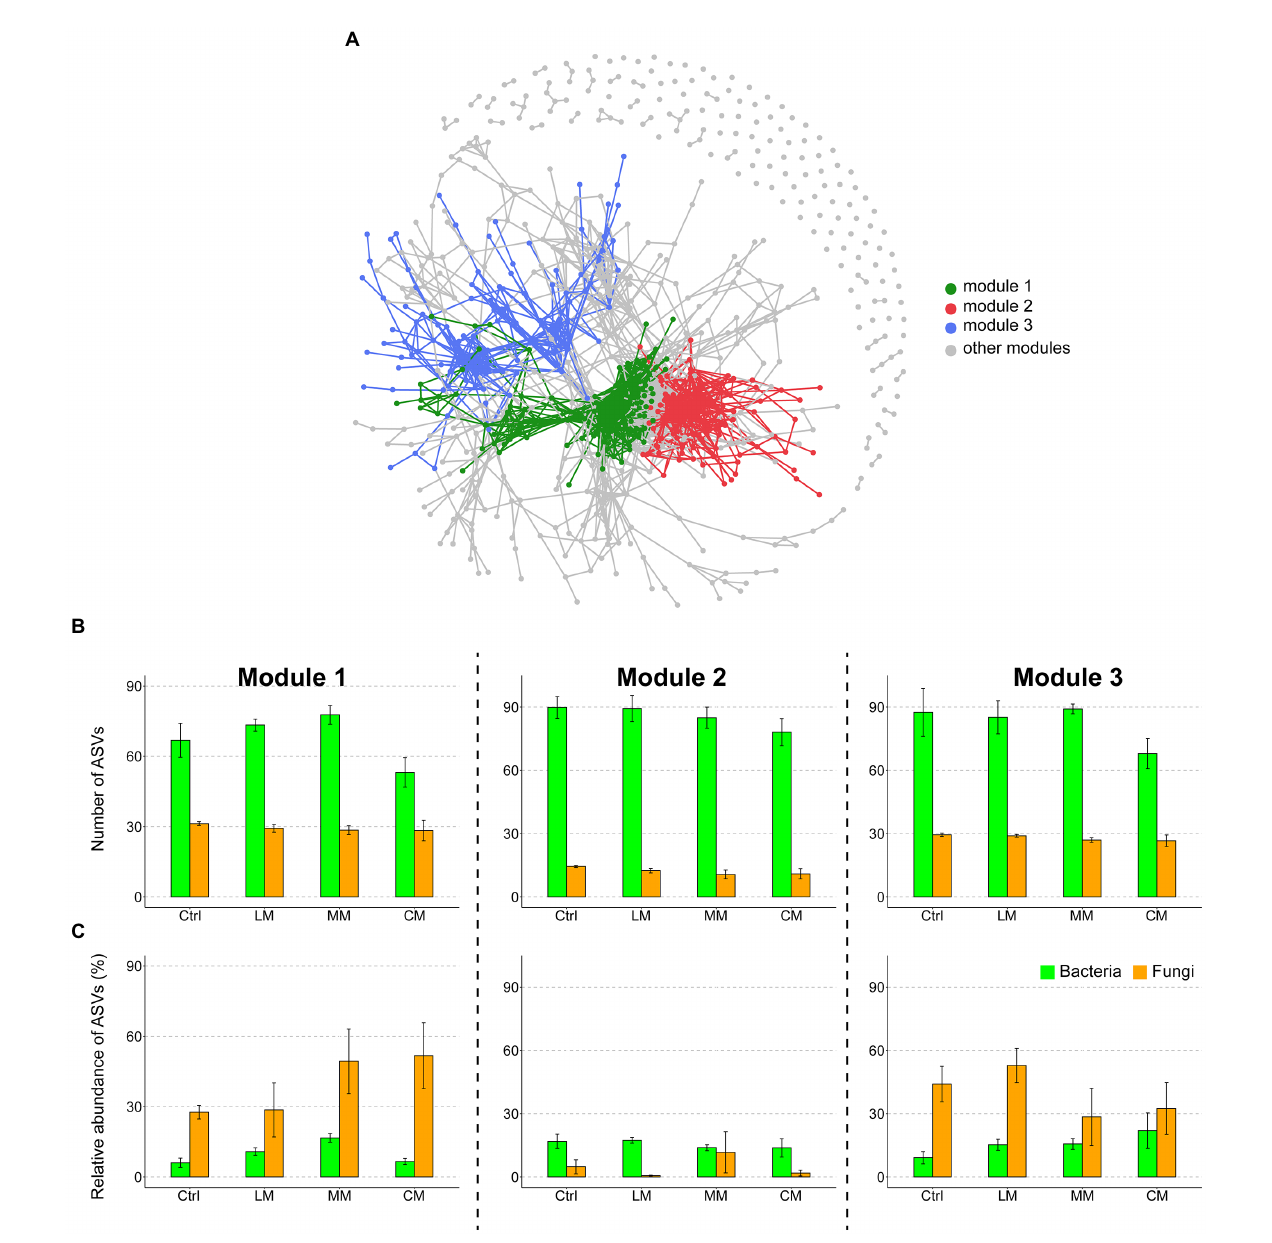
FIGURE 3 (A) Network co-occurrence patterns of the dominant bacteria and fungi across treatments. The modules are distinguished using different colors. (B) The number of amplicon variant sequence (ASVs) of bacteria and fungi in the three most important modules (modules 1–3). (C) Relative abundance of ASVs of bacteria and fungi in the three most important modules (modules 1–3) in different OAs treatments. Data are presented as means ± SD ( n = 6). Error bars depict standard deviations. Lowercase letters indicate significant differences ( p < 0.05) between the treatments. Ctrl (Control without OAs), LM (Addition of lignin-dominant OAs), MM (Addition of OAs with equal content of lignin and cellulose), and CM (Addition of cellulose-dominant